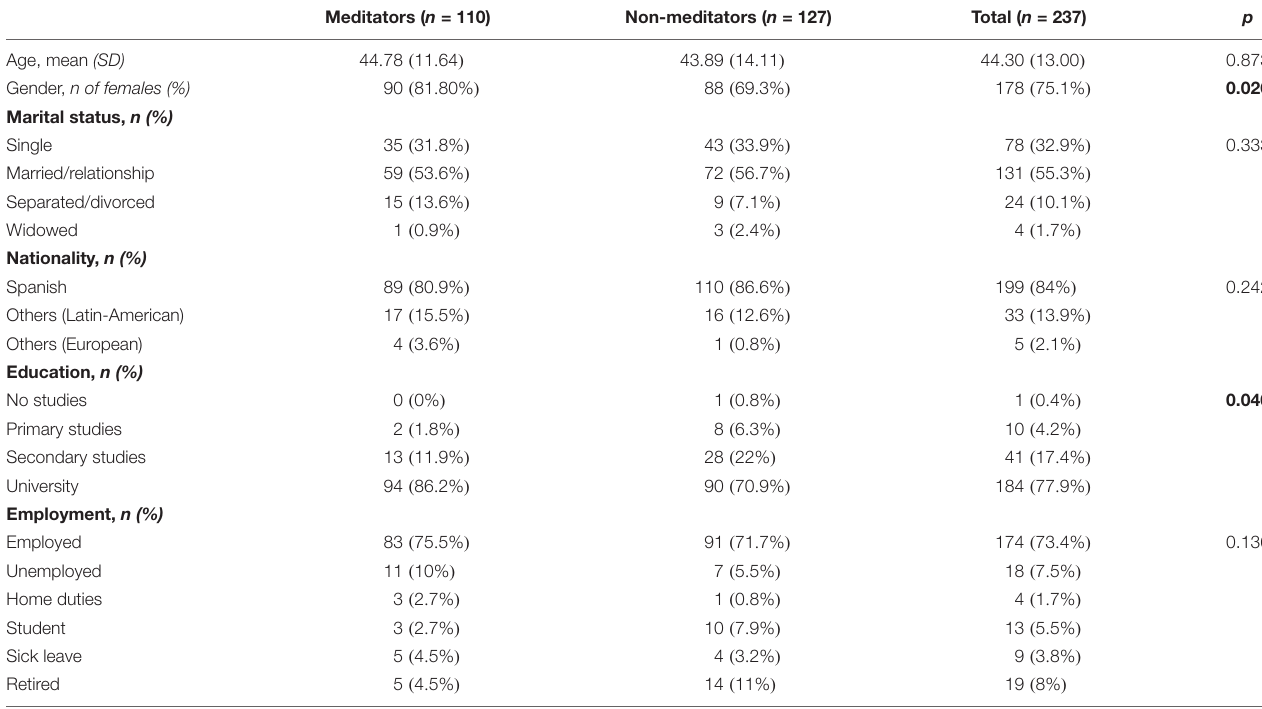
TABLE 1 | Baseline characteristics of patients by treatment